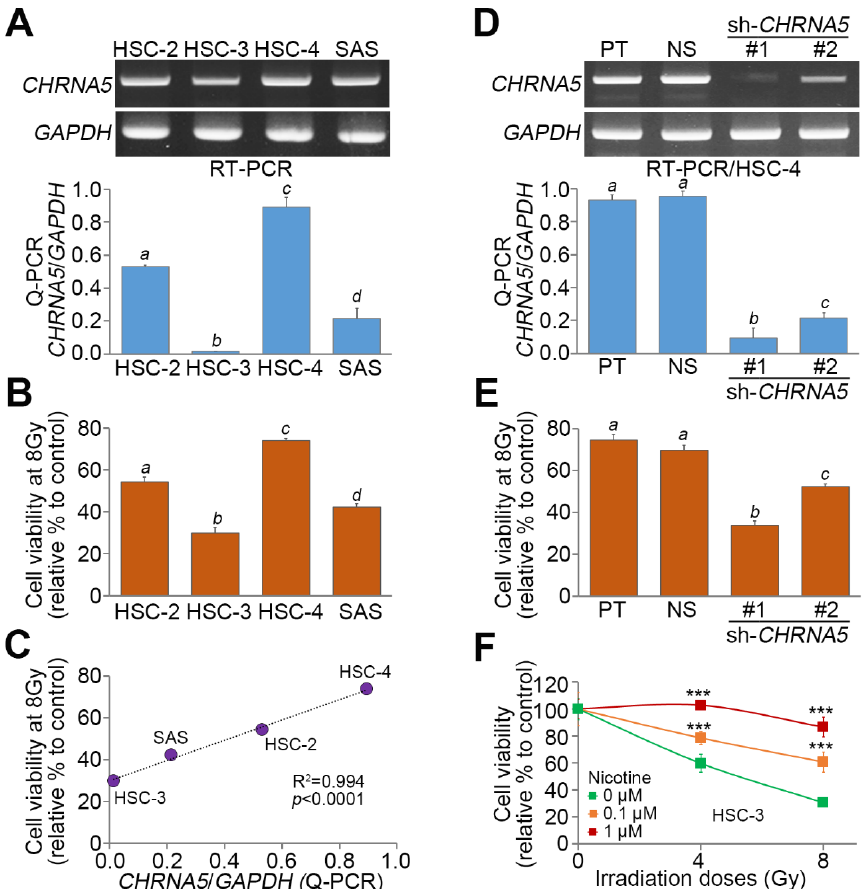
Figure 3. Endogenous CHRNA5 expression and radiosensitivity in OSCC cells. ( A ) mRNA levels of CHRNA5 , as measured by RT-PCR (upper) and Q-PCR (lower), in a panel of OSCC cell lines (HSC-2, HSC-3, HSC-4, and SAS). ( B ) Viability of the examined OSCC cells at 24 h after exposure to 8 Gy irradiation. ( C ) Doplot for the correlation between CHRNA5 expression and cell viability at 24 h after exposure to 8 Gy irradiation in the examined OSCC cell lines. ( D ) mRNA levels of CHRNA5, as measured by RT-PCR (upper) and Q-PCR (lower), in HSC-4 cells transfected without (parental, PT) or with nonsilencing (NS) control shRNA or with two independent shRNA clones targeting CHRNA5 . ( E ) Viability of the detected HSC-4 cell variants at 24 h after exposure to 8 Gy irradiation. ( F ) Viability of HSC-3 cells pretreated with nicotine at the indicated concentrations for 24 h, measured at 24 h after exposure to the designated doses of irradiation. In ( A , B , D – F ), the error bars denote the data from three independent experiments presented as the mean ± SEM, and the di ff erent letters indicate the statistical significance at p < 0.001 estimated by the nonparametric Friedman test. In ( F ), the symbol “***” denotes p <